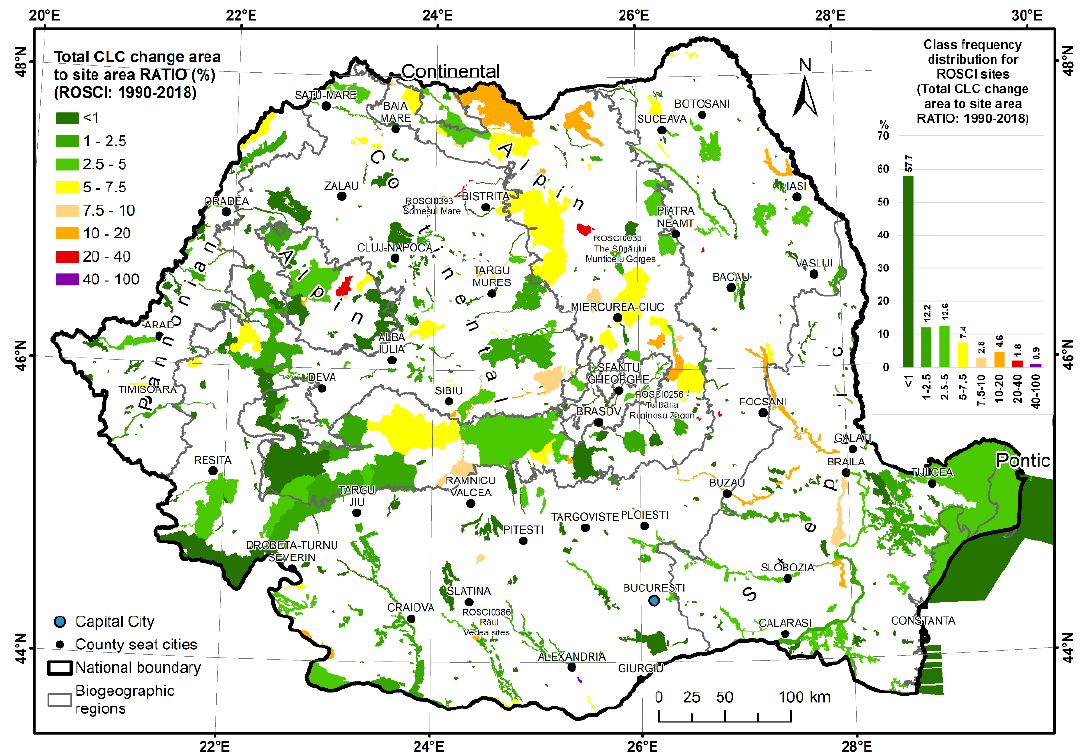
Figure 1. Changed area to site area ratio (%) for ROSCI-Romanian Sites of Community Importance (1990–2018).